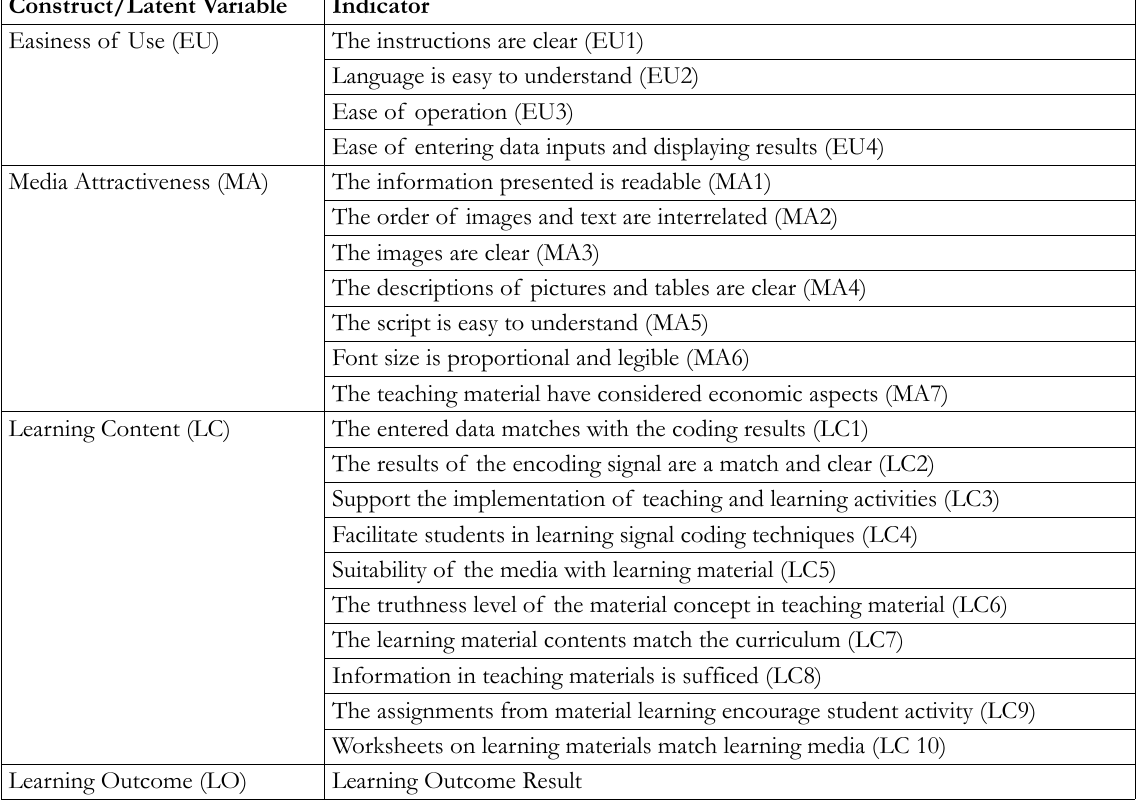
Table 1. Latent variable and its